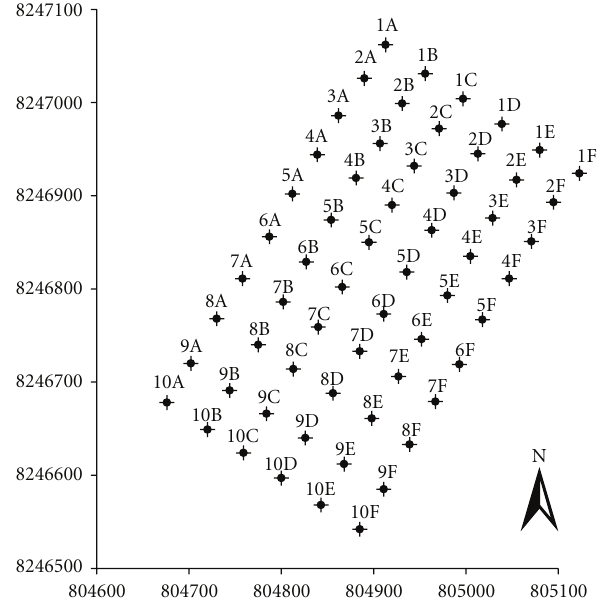
Figure 1: Location of the points of geophysical researches in the gravel pit. Datum: Astro